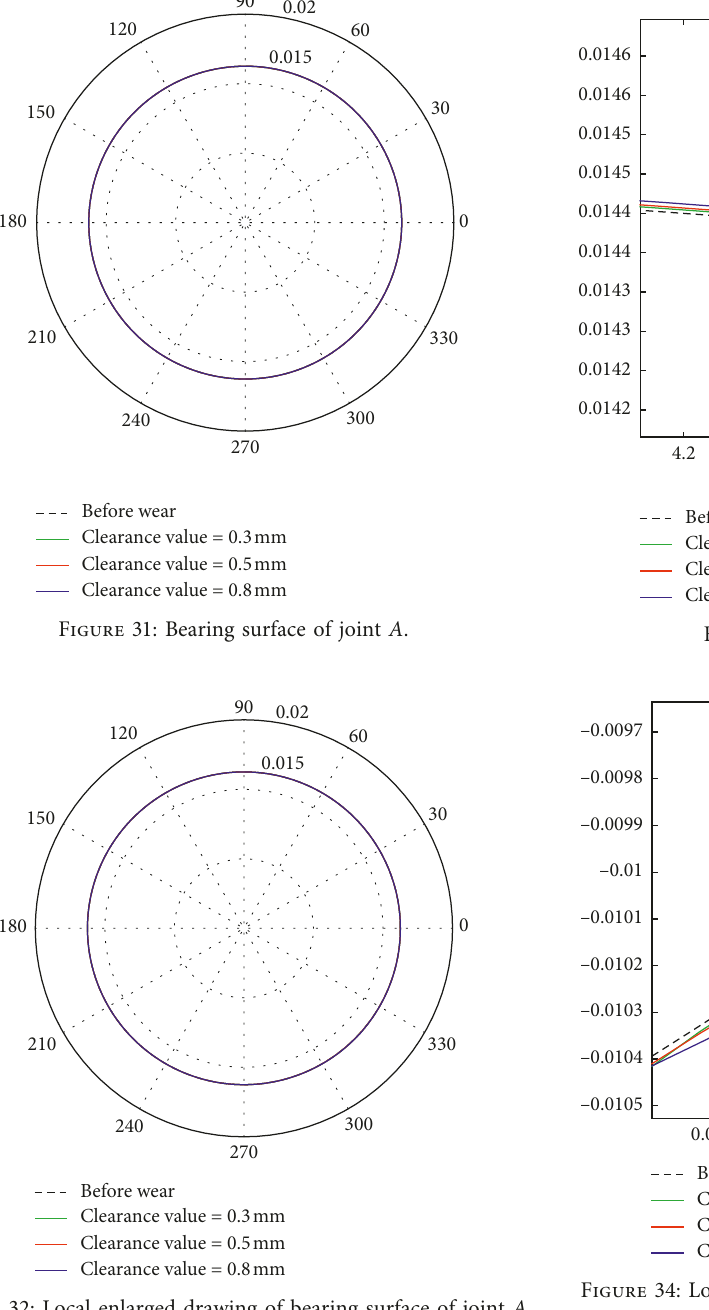
Figure 32: Local enlarged drawing of bearing surface of joint A .